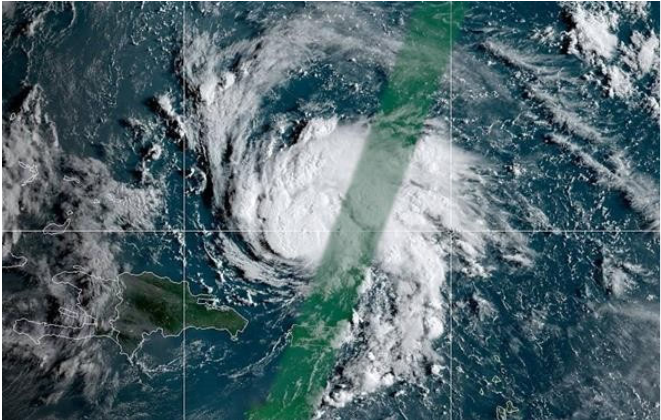
Figure 5. Hurricane Dorian over Puerto Rico [29].